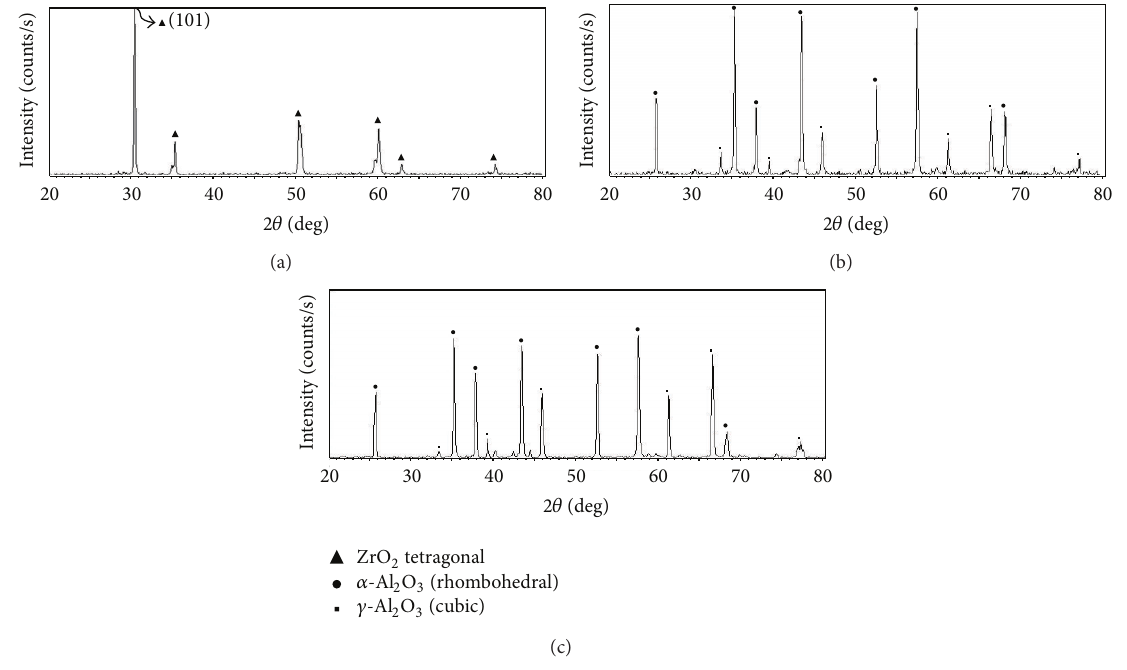
Figure 8: XRD patterns of (a) normal YSZ layer, (b) nano-Al 2 O 3 coating, and (c) normal Al 2 O 3 coating after air plasma spraying.